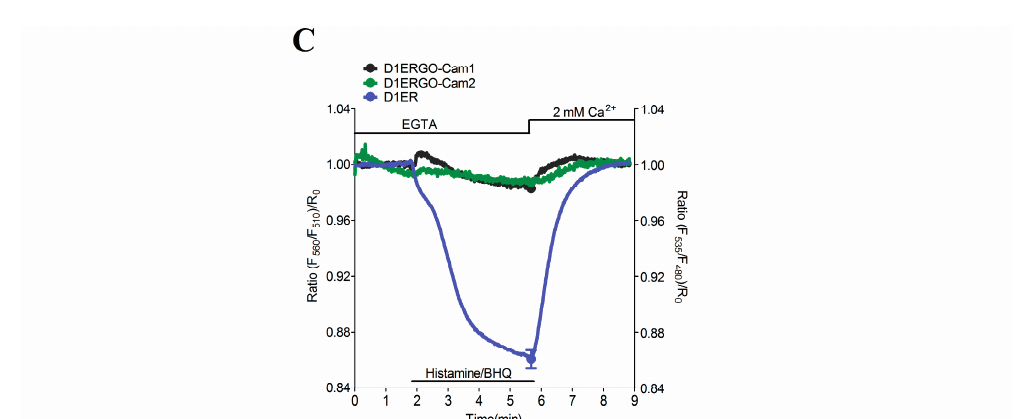
Figure 1. Evaluation of GFP/OFP cameleons upon ER targeting: ( A ) schematic composition of D1ERGO-Cam1 and D1ERGO-Cam2; and ( B ) representative confocal images for colocalization analysis. INS-1 cells were co-transfected with D1ER and either D1ERGO-Cam1 or D1ERGO-Cam2, respectively. Images of GFP/OFP-based cameleons were taken from the mKO emission at 570 nm (left panels); D1ER was monitored in its CFP emission at 480 nm (middle panels); and an overlay of images (right panels); ( C ) Average curves of FRET measurements in HeLa cells expressing either D1ER (cyan curve, n = 14), D1ERGO-Cam1 (dark grey curve, n = 10) or D1ERGO-Cam2 (green curve, n = 7) upon treatment with 100 µM histamine and 15 µM BHQ in the absence of extracellular Ca 2+ . SOCE was accomplished by the subsequent addition of 2 mM Ca 2+